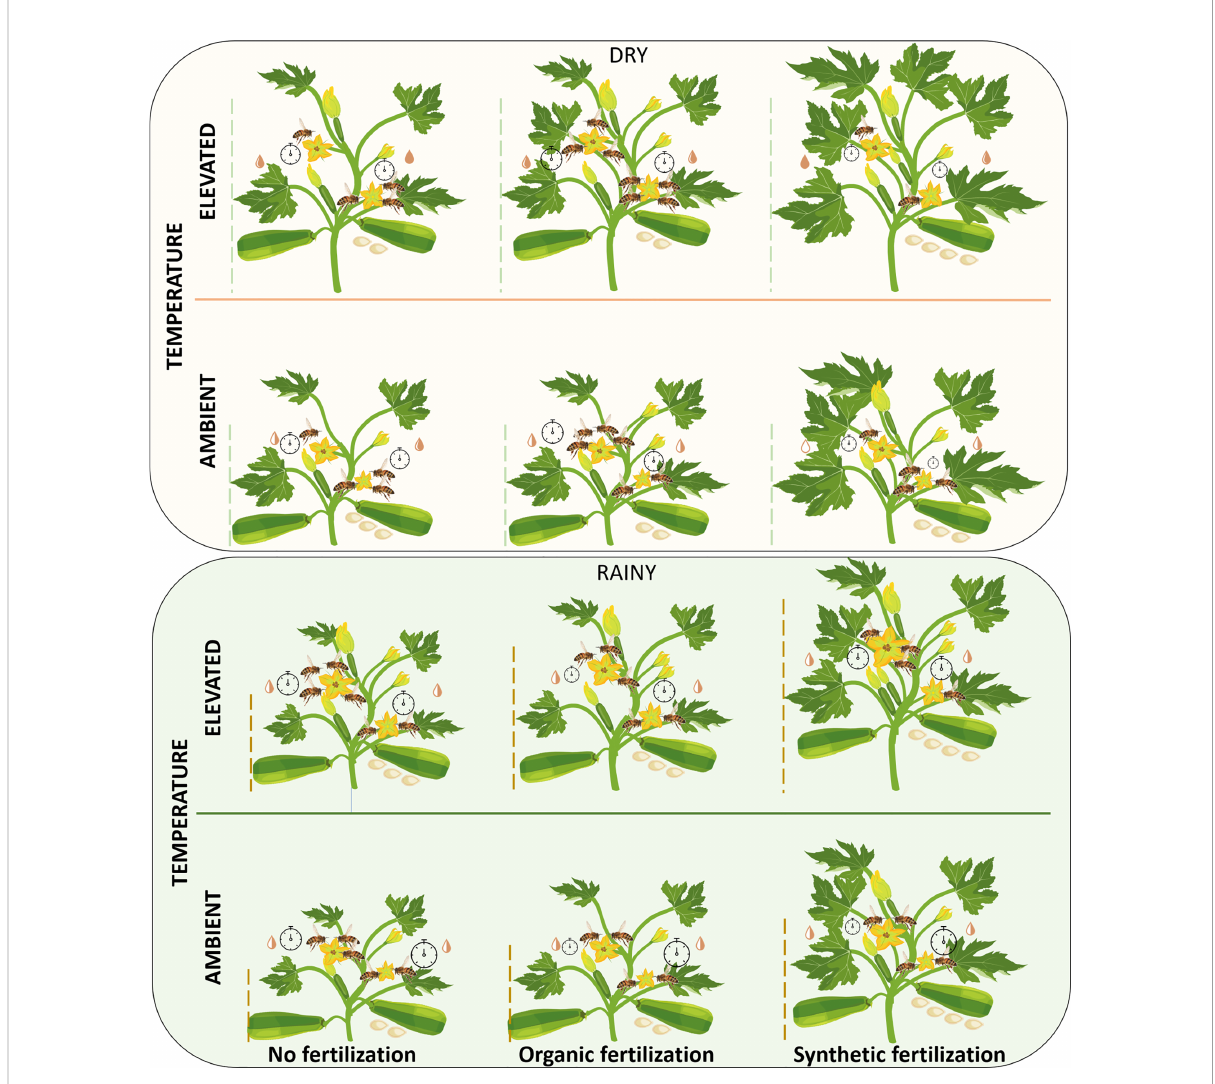
FIGURE 9 Schematic representation of increased temperature and fertilizer impacts on vegetative and fl oral traits, legitimate fl oral visitors, and reproductive success of C. pepo plants grown in the dry (top) and rainy (bottom) seasons. An increase in the size or number of parts indicates a signi fi cant increase in that variable. The dotted lines represent the height of the plants. The number and size of pistillate fl owers are represented by and , respectively. Number and size of staminate fl owers are represented by and , respectively. The volume and concentration of the nectar is represented by the symbol , fuller symbols indicate greater concentration. The number of bees in each fl ower represents the visitation rate of legitimate fl oral visitors. The duration of the visits is represented by the size of the . Fruit set is represented by the number of fruits on the plants and the number of seeds is represented by the number of seeds under the fruits. Nectar volume and concentration, visitation rate, and visitation duration are shown, respectively on the left and right side of each plant for pistillate and staminate fl owers. No statistical comparisons were performed between pistillate and staminate fl owers, nor between dry and rainy seasons. For speci fi c analyses, data and statistical values see Supplementary Tables 1 – 3 and Figures 2 –